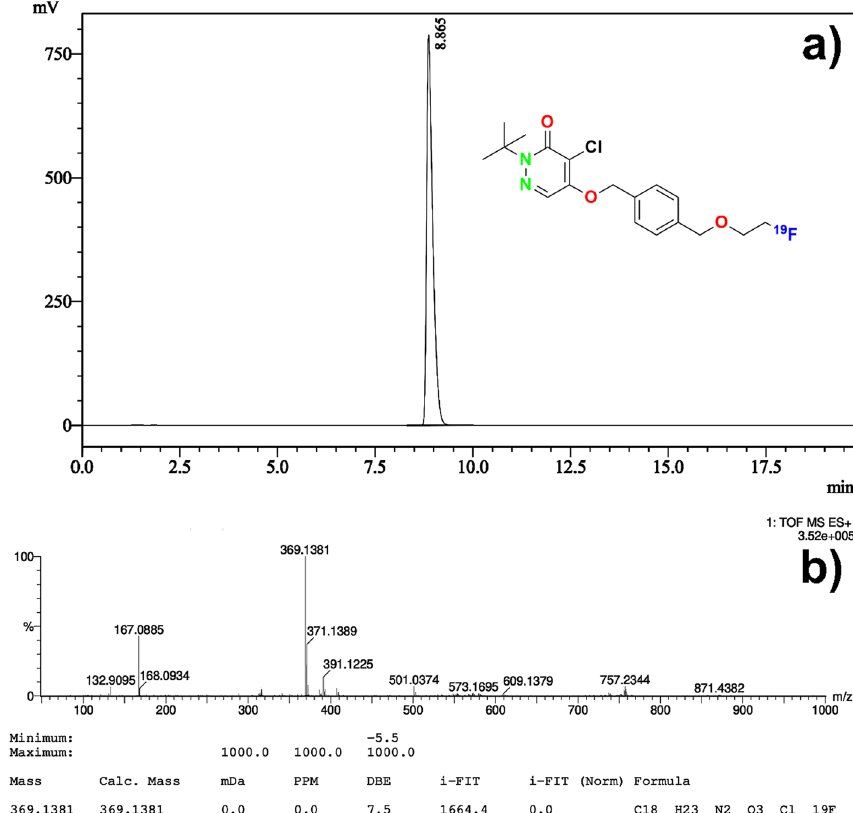
Fig. 4 HPLC UV chromatogram and identification of [ 19 F]Flurpiridaz ( 7 ) ( a ), HR-MS analysis of [ 19 F]Flurpiridaz ( 7 ) ( b